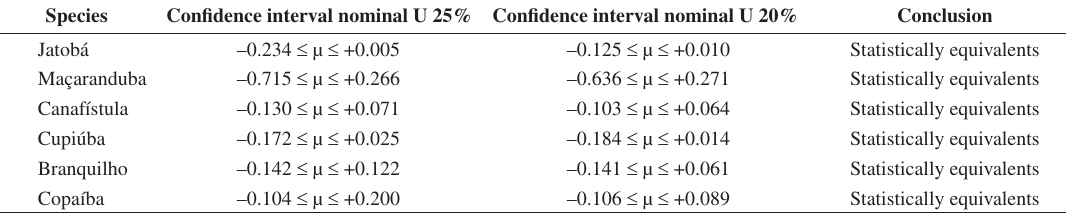
Table 5. Confidence intervals of average differences: E12/Eu (Exp) e E12/Eu (4). Species